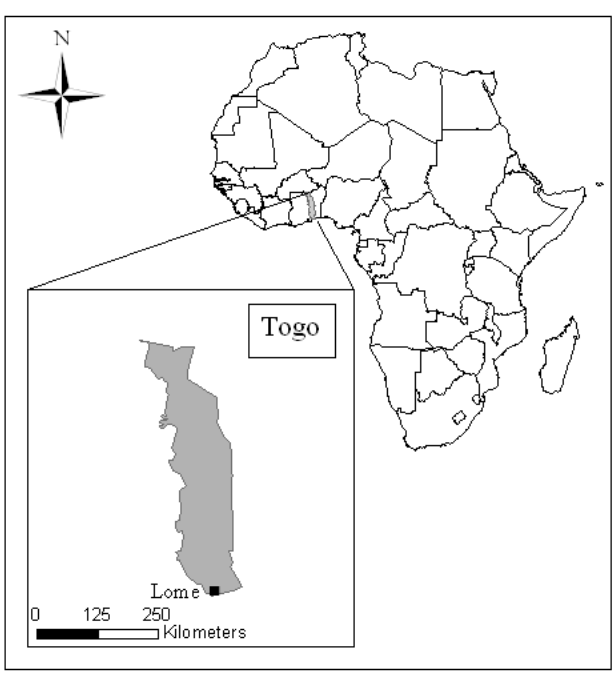
Figure 1. Location of Lomé,